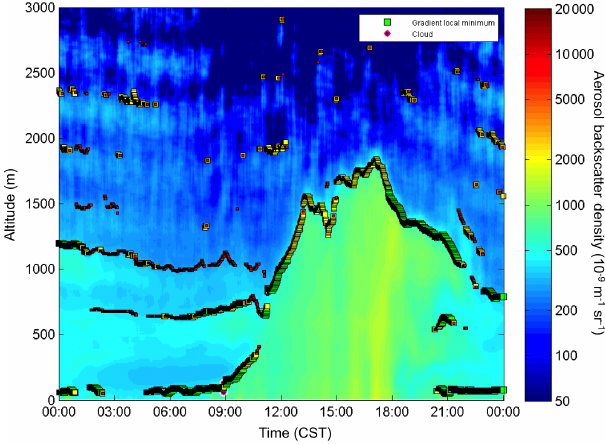
Figure 3. Aerosol backscatter time series for 24 October 2013. Three gradient local minimums are plotted for each 1min aerosol backscatter